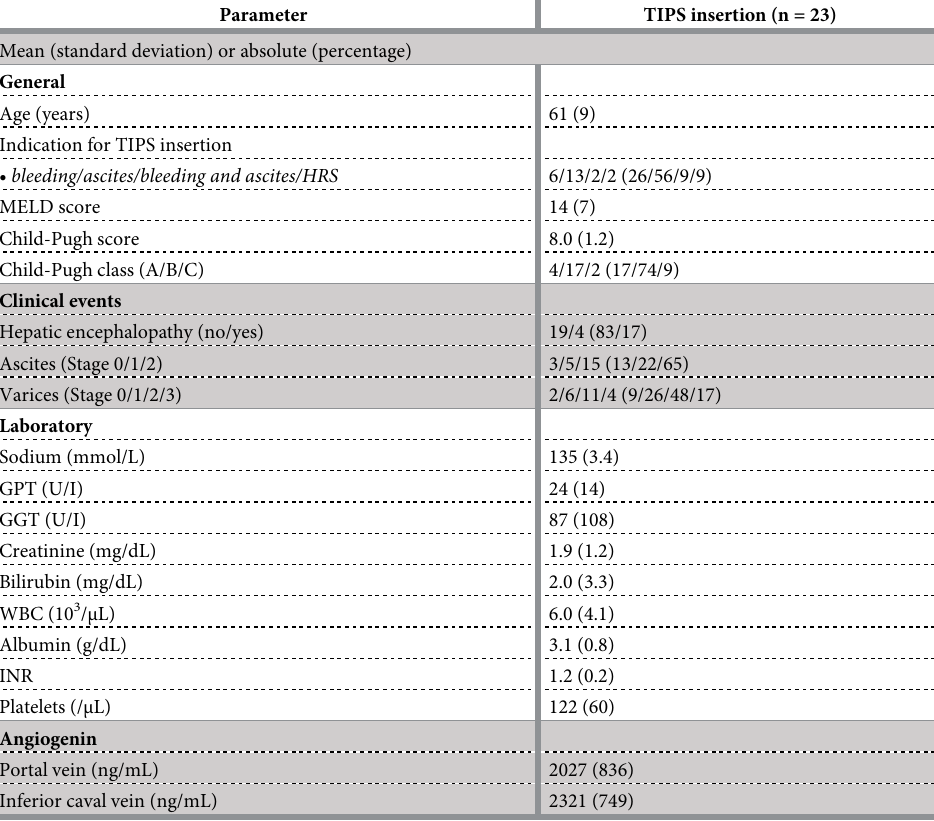
Table). Mean portal vein angiogenin levels were significantly lower compared to the levels in the inferior caval vein (portal vein: 2027 ng/mL; inferior caval vein: 2321 ng/mL; P = 0.048) (Table 1) (Fig 1). We observed neither a significant difference, nor a correlation between angiogenin concentrations and the year of blood sampling (S2 Fig). Angiogenin concentrations in the inferior caval vein are inversely correlated with PHPG after TIPS Angiogenin levels were measured in 72 samples of 39 patients in portal and inferior caval vein plasma (each compartment: n = 36) of 39 patients receiving control angiography after TIPS insertion. At this timepoint, mean MELD score was 10, while hypoalbuminemia (3.0 g/dL), low platelet count (125/ μ L) and increased GGT levels (151 U/I) were observed as surrogate markers of advanced liver disease and PH. Mean angiogenin levels in the portal and the inferior caval vein were not significantly different (portal vein: 2014 ng/mL and inferior caval vein: 2282ng/mL; P = 0.4) (Table 2). Twenty-two of the 39 patients (56%) received TIPS revision due to TIPS dysfunction, defined by radiological flow criteria at control angiography, whereby MELD score and other general laboratory parameters were Table 1. Characteristics of patients at TIPS insertion. Parameter TIPS insertion (n = 23) Mean (standard deviation) or absolute (percentage) General Age (years) 61 (9)